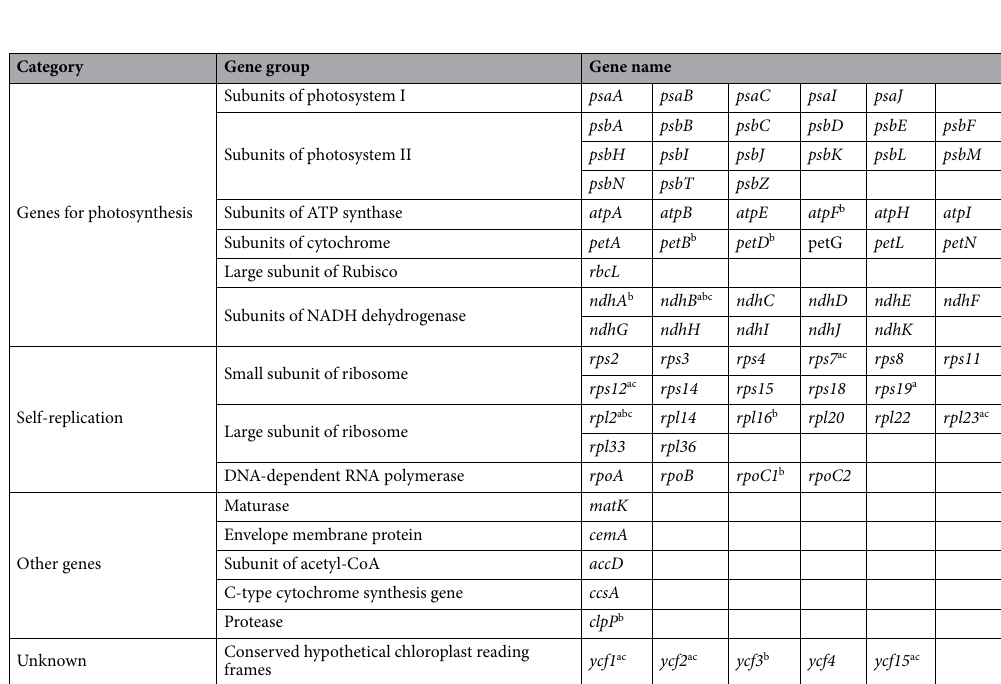
Table 2. List of protein-coding genes present in the A. episcopale chloroplast genome. a Genes located in the IR regions. b Genes have introns. c Two gene copies in